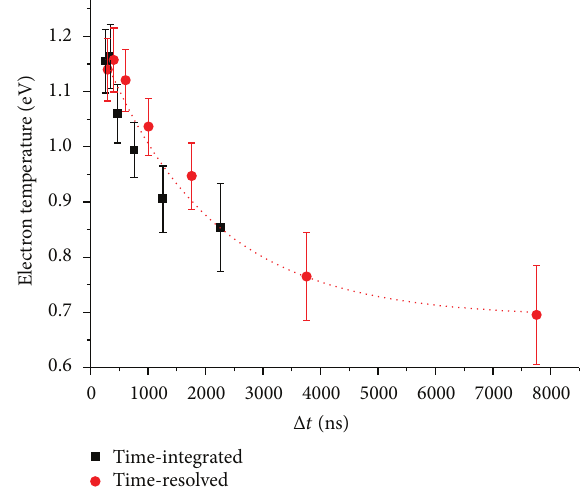
Figure 8: Comparison of plasma electron temperature evaluated from time-integrated and time-resolved spectra. The dotted line represents the best exponential fit of the